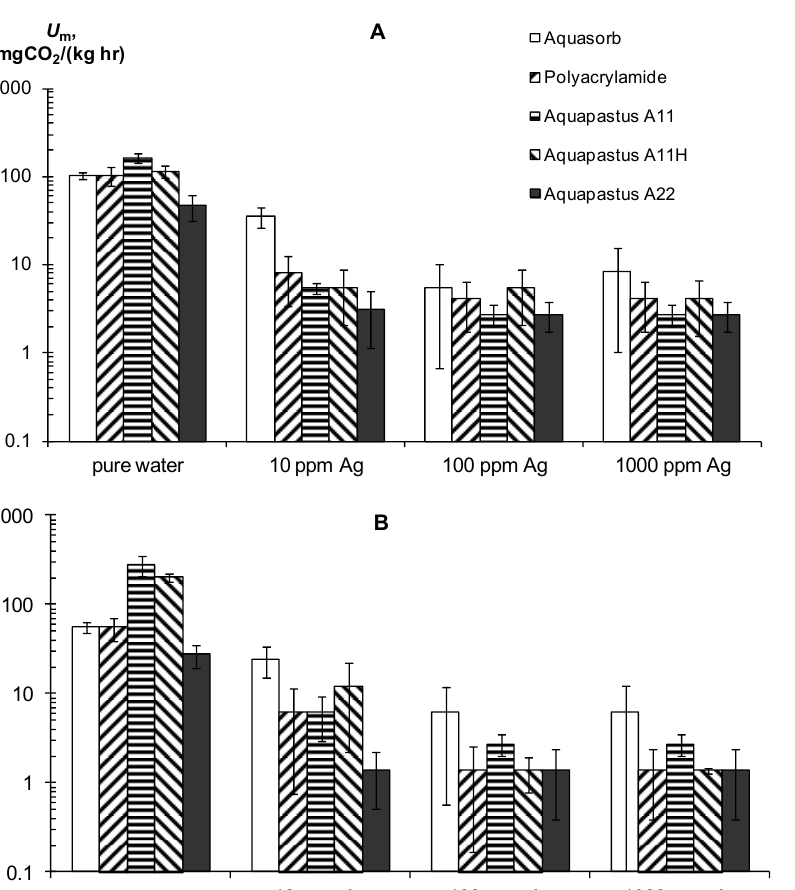
Figure 5. Basal respiration as an indicator of resistance to biodegradation of the hydrogels and their compositions with silver. ( A ) — ionic silver, ( B ) — silver nanoparticles (according to [30]).